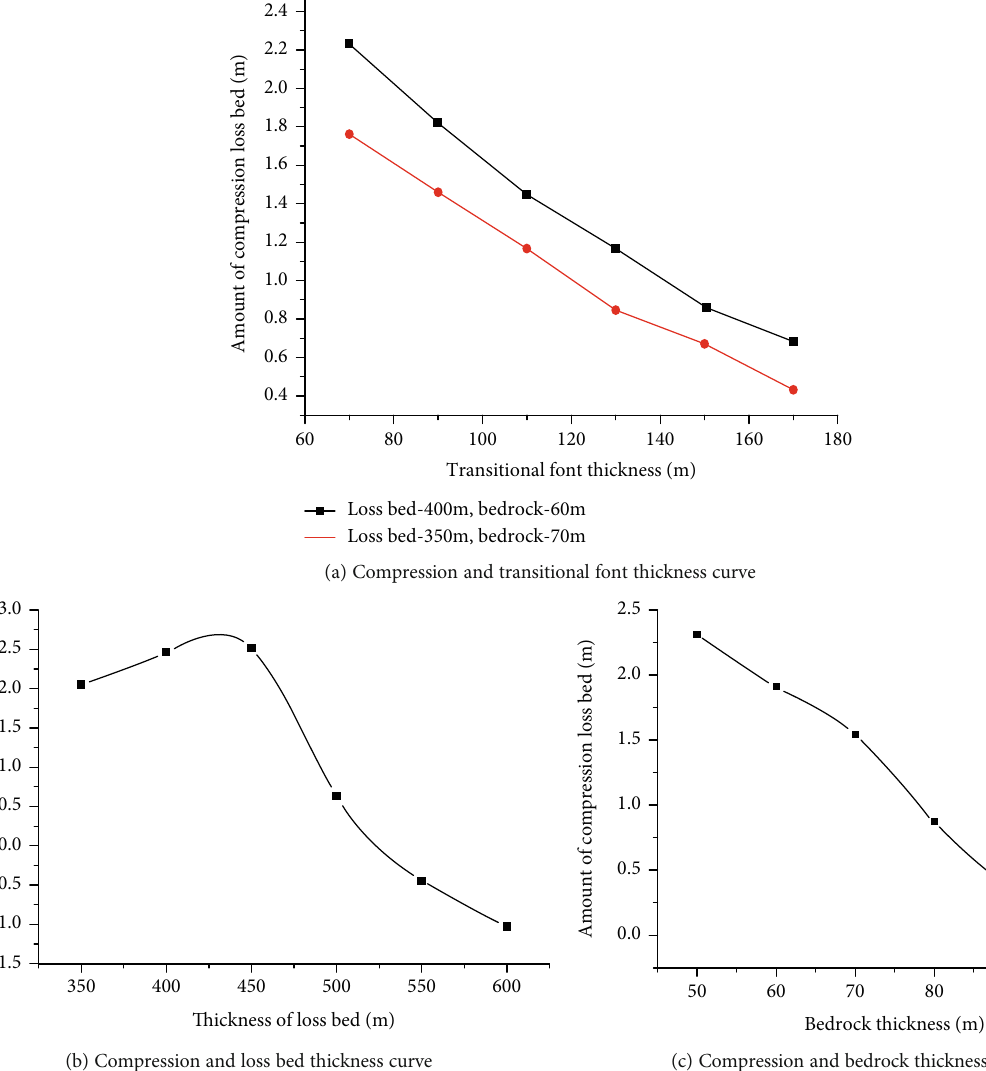
Figure 16: Compression and variation of di ff erent formation